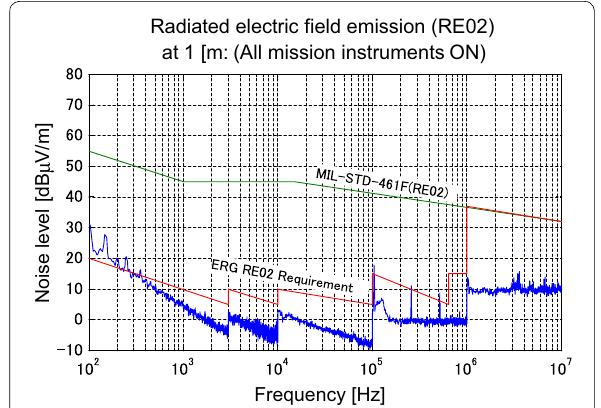
Fig. 6 Radiated electric field noise (RE02) measured in the system electromagnetic compatibility (EMC) test